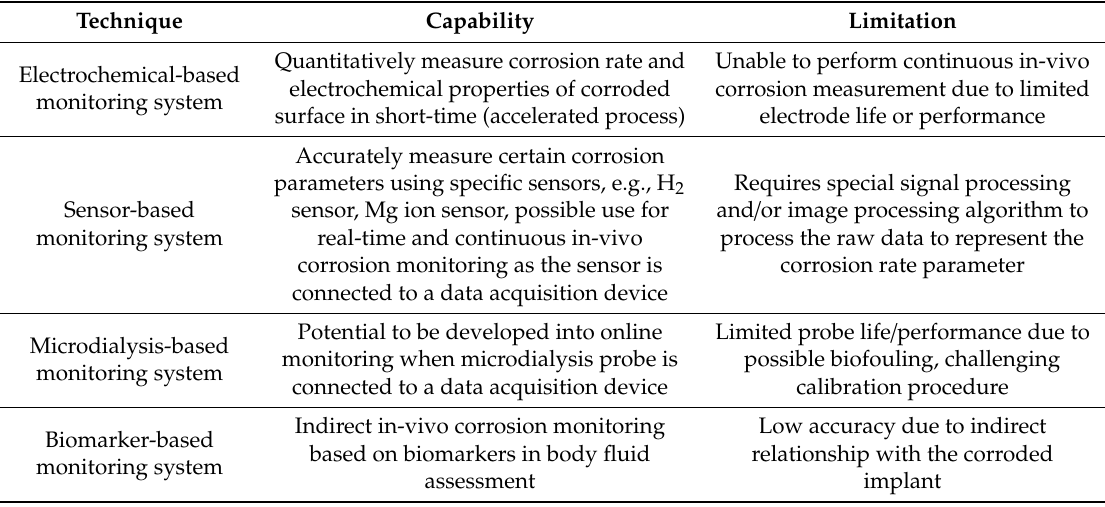
Table 3. Comparison of capabilities and limitations of available systems for real-time in-vivo corrosion monitoring of absorbable metal